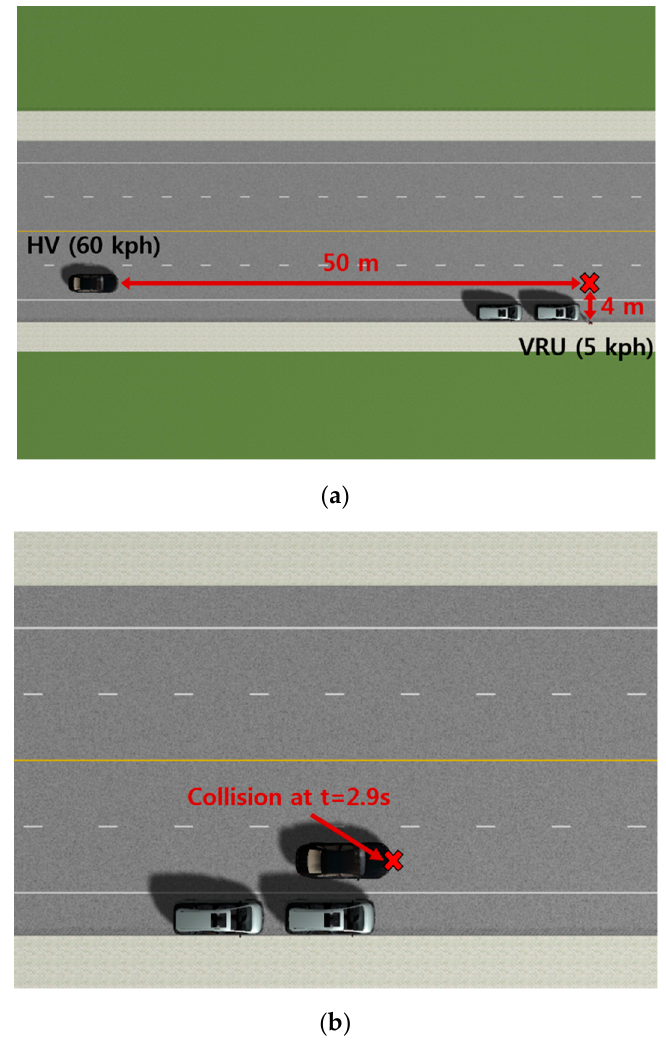
Figure 8. Simulation environment for the vehicle–pedestrian collision scenario: ( a ) Experiment setup at the start of the simulation; ( b ) collision between the host vehicle and the pedestrian at the end of the simulation.